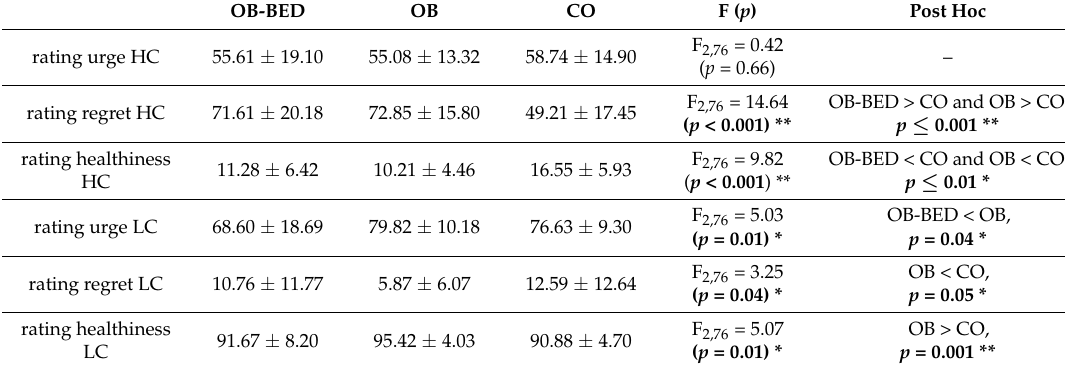
* and ** indicate a ≤ 0.05 and < 0.001 level of significance, respectively.